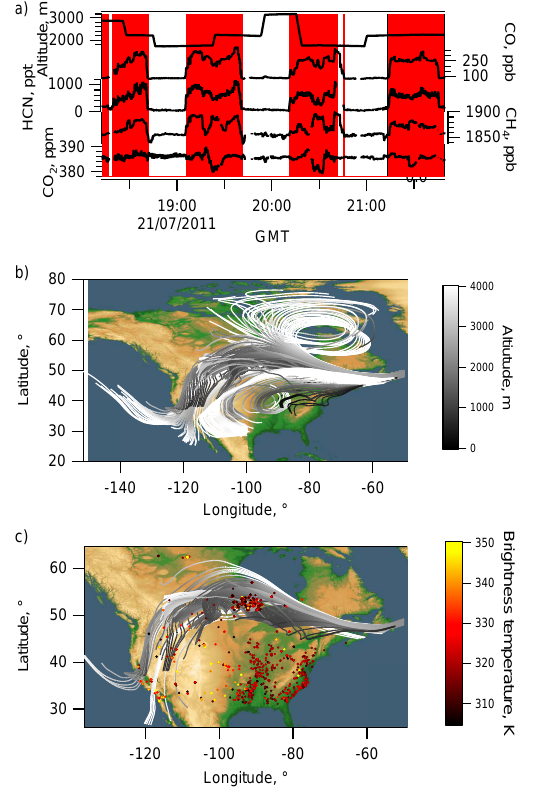
Fig. 7. (a) Time series whilst sampling a biomass burning plume near the coast of Newfoundland during flight B624. The red back- ground indicates that the sampling was in a BB plume. (b) HYS- PLIT 5-day back trajectories for the whole of flight B624. The tra- jectories were started at 60s intervals along the flight starting point. (c) Only the back trajectories that end whilst flying in a biomass burning plume, as identified by the in situ HCN and CO measure- ments on the FAAM BAe-146. Markers are active fires detected by MODIS for the 5 days prior to the flight.